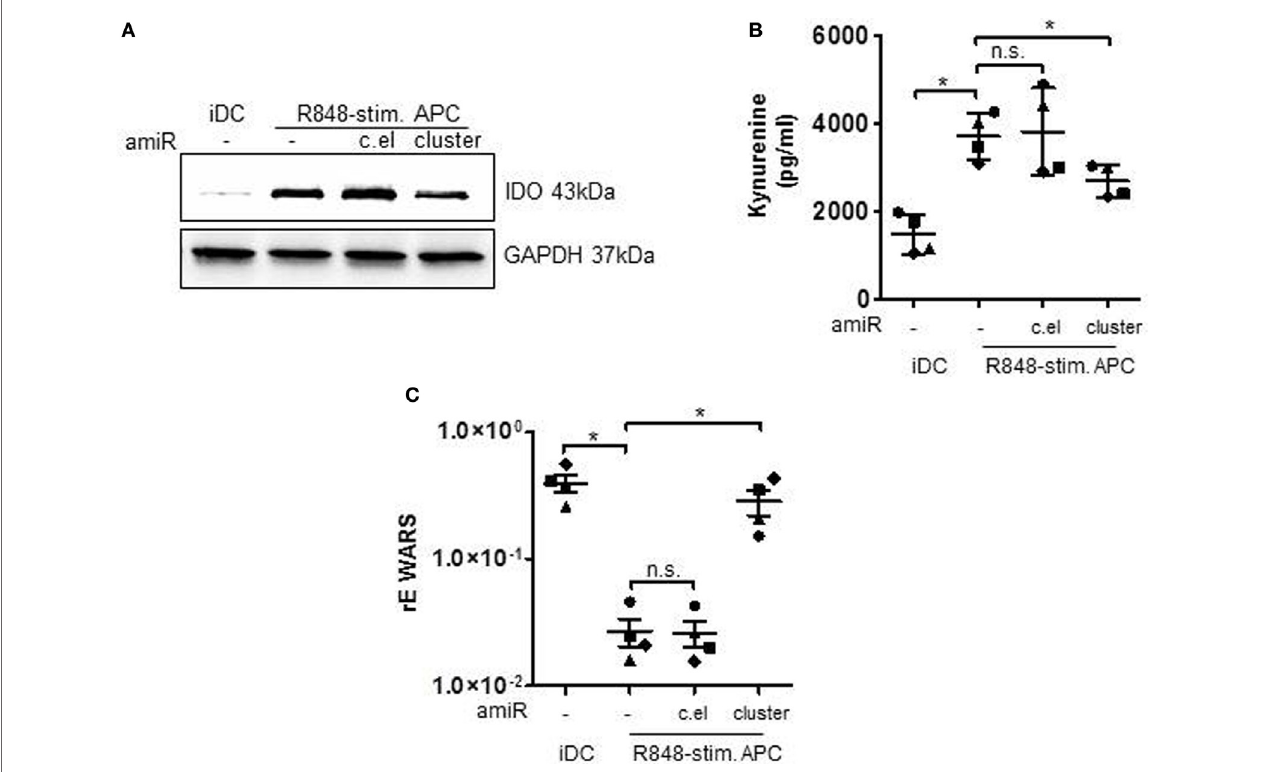
FigUre 5 | Immature DCs (iDCs) and R848-stimulated APCs, treated with either antagomiRs (amiRs) against miRNA cluster (miR-99b/let-7e/miR-125a) or against c.el miRNA (control) or untreated were analyzed in the following way. (a) Lysates were produced and Western blots for the detection of indolamin-2,3-dioxygenase (IDO) were performed. GAPDH served as loading control. Depicted is one example out of three experiments with similar results. (B) The amount of IDO-generated kynurenine was measured in the supernatant of the cells. (c) RNA was isolated, cDNA generated, and qRT PCRs with sequence-specific primers for WARS and SYBRGreen were performed. Results were normalized against Actin. (B,c) Each symbol represents one donor. Shown is mean and SD. Statistics: * p ≤ 0.05 by Mann–Whitney U